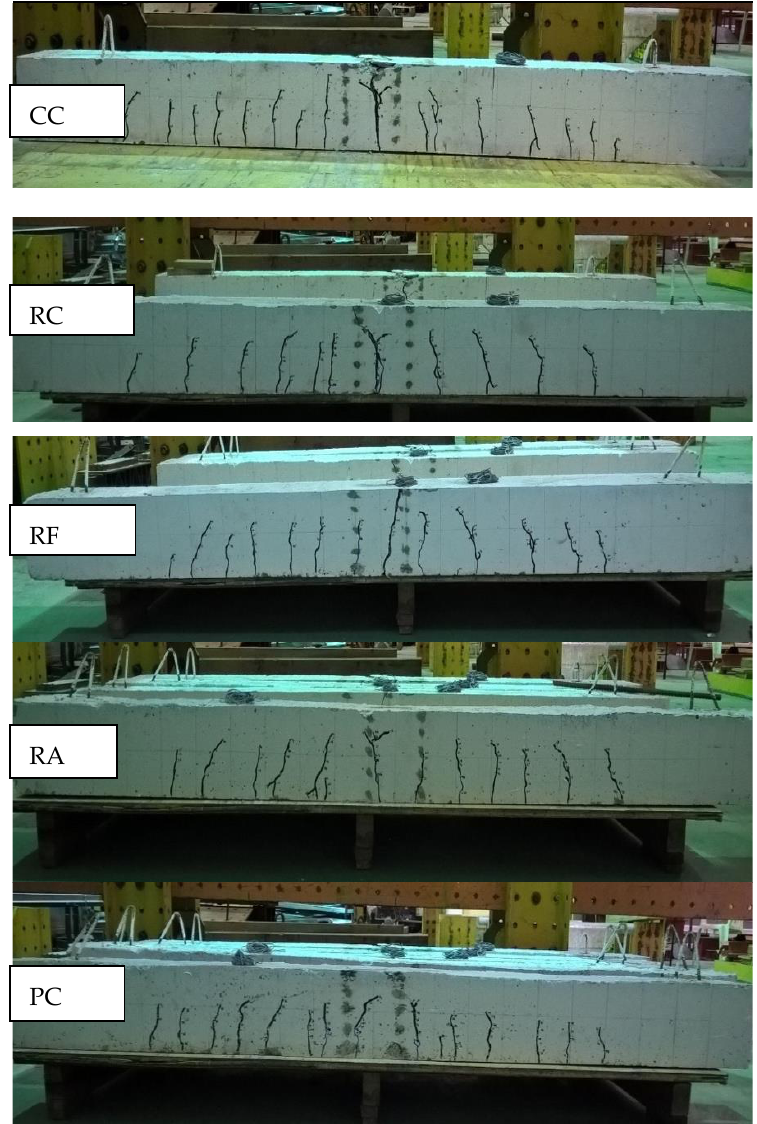
Figure 15. Distribution of cracks in all specimens.